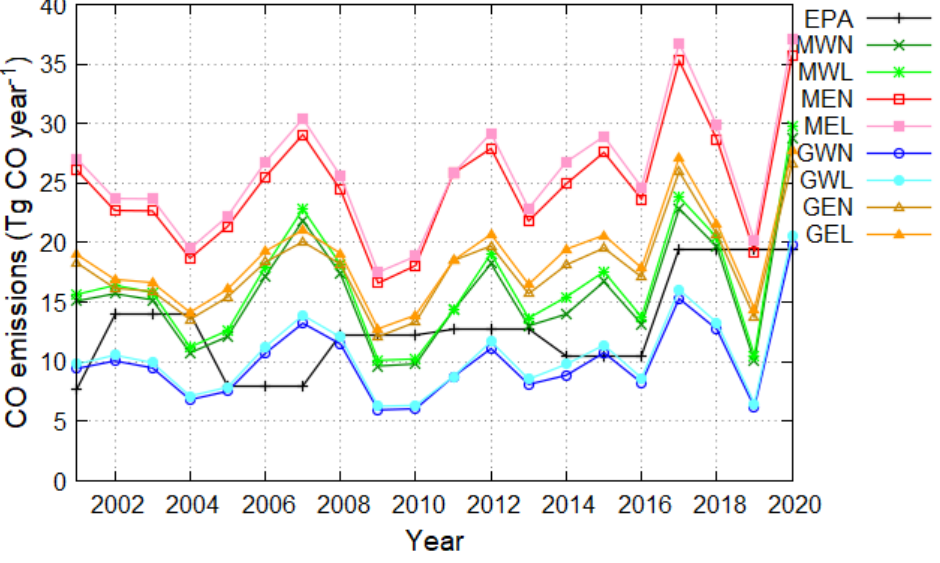
Figure 6. Comparison of CO emissions between EPA and estimated eight results in the United States.